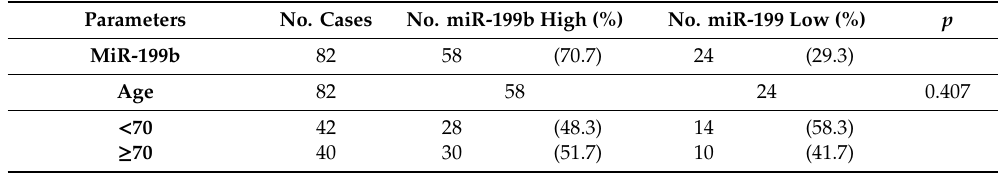
Table 1. Association between miR-199b and clinical and molecular parameters in 82 locally advanced rectal cancer (LARC)